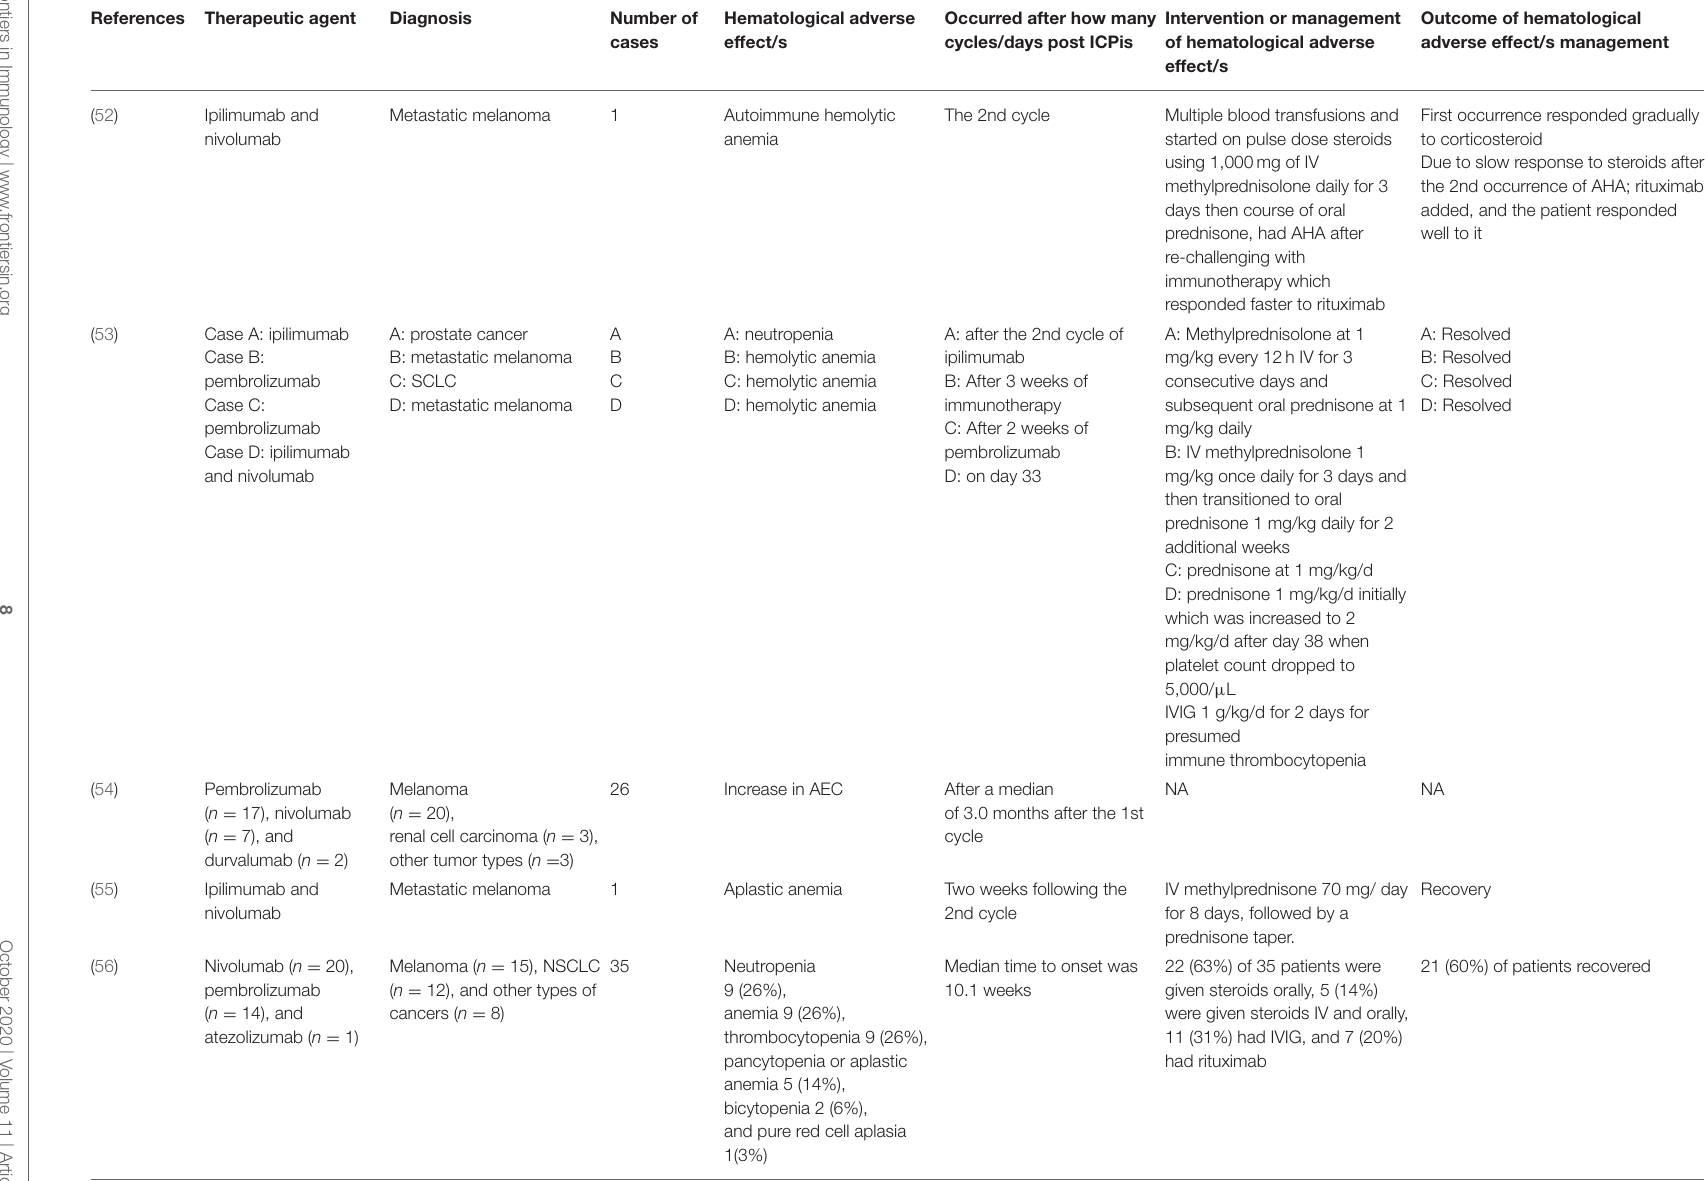
ICPi, Immune Check Point inhibitors; IVIG, Intravenous Immunoglobulin; IVATG, Intravenous Anti-thymocyte Globulin; CSF, Colony Stimulating Factor; G-CSF, Granulocyte Colony Stimulating Factor; GM-CSF, Granulocyte-Macrophage Colony Stimulating Factor; RBC, Red Blood Cells; NA, Not Available; ITP, Idiopathic Thrombocytopenic Purpura; SCLC, Small Cell Lung Carcinoma; AEC, Absolute Eosinophil Count; NSCLC, Non-Small Cell Lung Carcinoma; AHA, Autoimmune Hemolytic